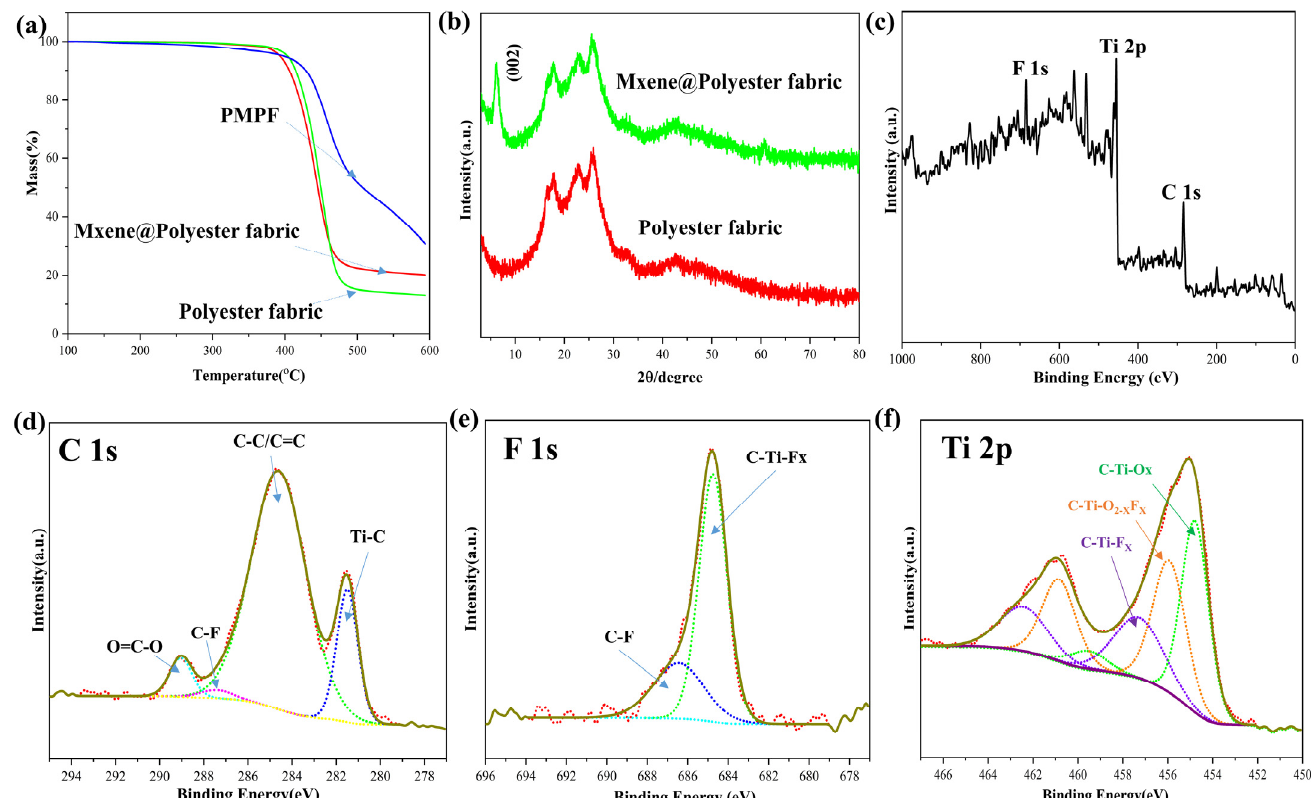
Figure 3. ( a ) TGA data for polyester fabric, MXene@polyester fabric, and PMPF; ( b ) XRD data for polyester fabric and MXene@polyester fabric; ( c – f ) XPS data for MXene@polyester fabric.